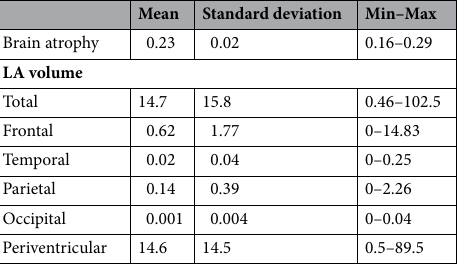
Table 1. Descriptive characteristics of brain structures ( n = 101). LA leukoaraiosis.